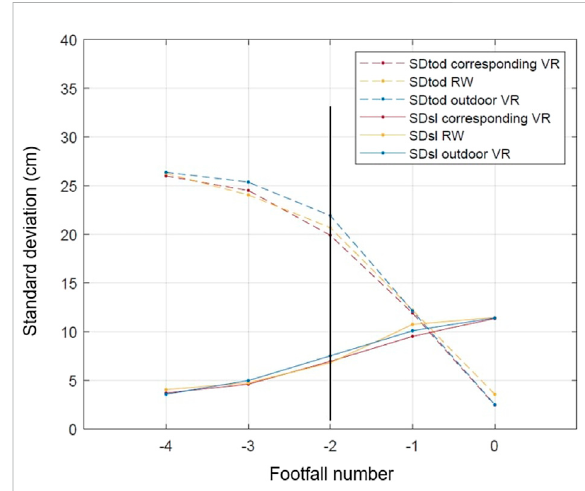
FIGURE 9 Patterns of the standard deviation of toe-obstacle distances and of step lengths as functions of footfall number. The black vertical line marks the onset of step adjustments at footfall − 2. Footfall0isthepointing footfall.SDtod: standarddeviation of toe-obstacle distances; SDsl: standard deviation of step lengths; VR: virtual reality; RW: real world.